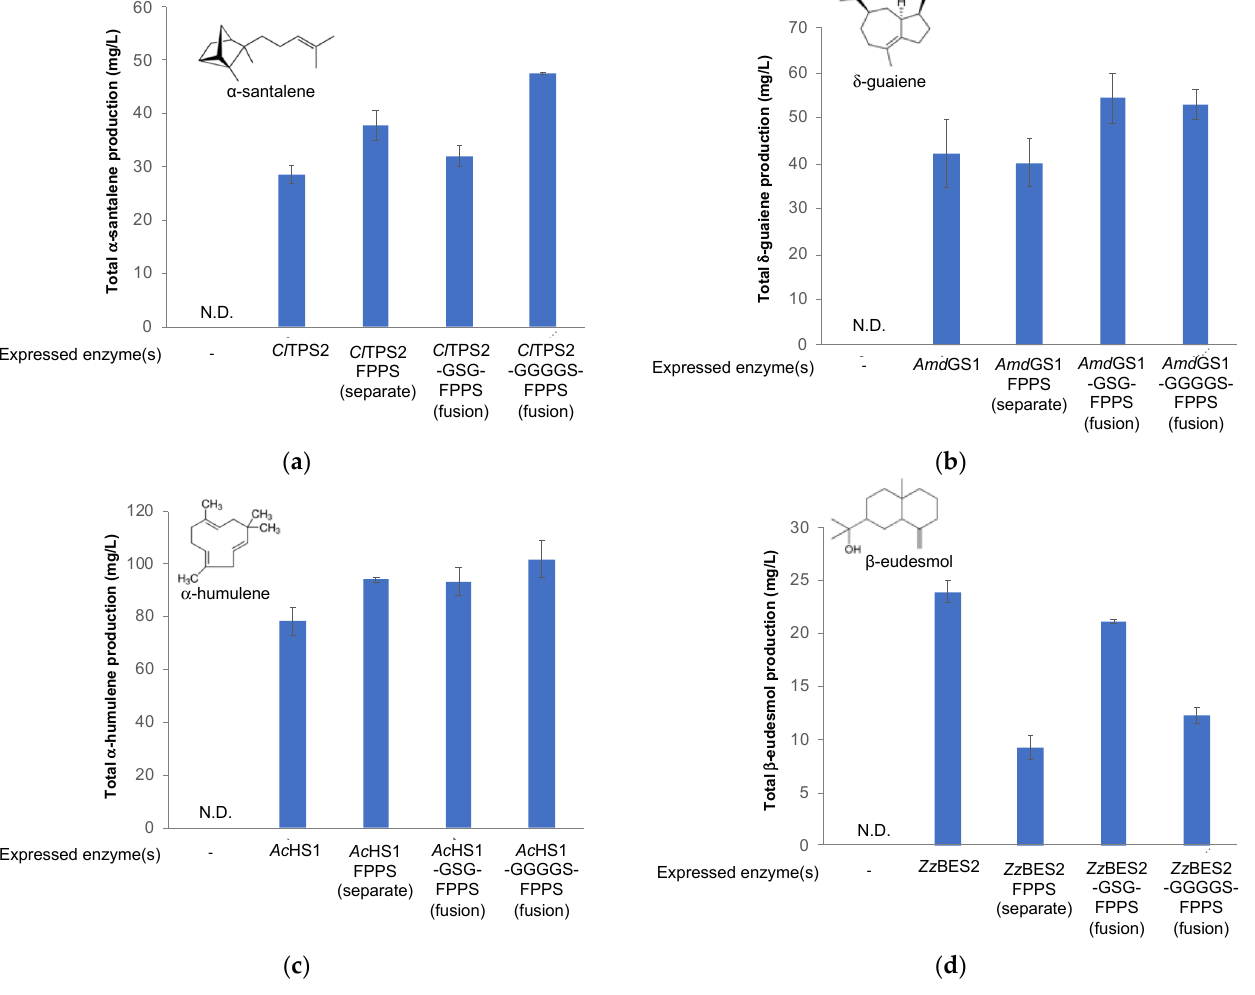
Figure 8. Improving fragrant terpenoid production via enzyme fusion. ( a ) Production of α -santalene in engineered strains overexpressing Cl TPS2 either alone or as fusion enzymes with FPPS; ( b ) Pro- duction of δ -guaiene in engineered strains overexpressing Amd GS1 either alone or as fusion enzymes with FPPS; ( c ) Production of α -humulene in engineered strains overexpressing Ac HS1 either alone or as fusion enzymes with FPPS; ( d ) Production of β -eudesmol in engineered strains overexpressing Zz BES2 either alone or as fusion enzymes with FPPS. N.D. not detected.